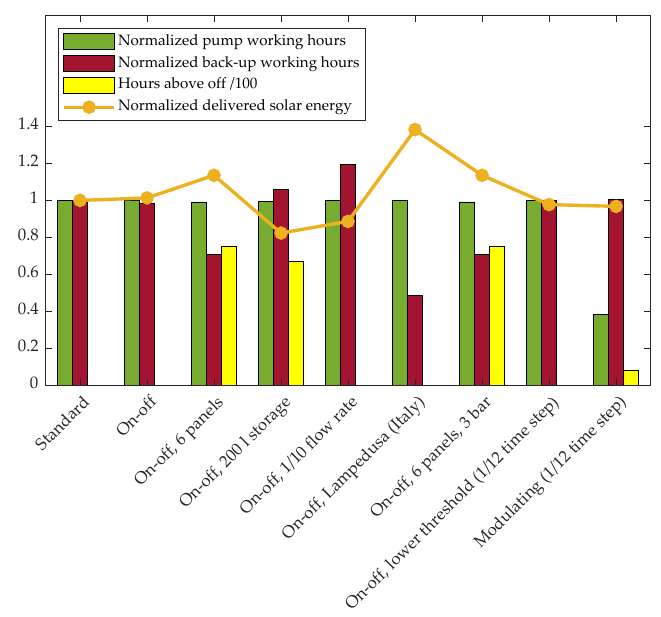
Figure 17. Comparison between yearly simulation results in different conditions. Pump working hours, back-up working hours and delivered solar energy are normalized over the corresponding values obtained for “Standard”